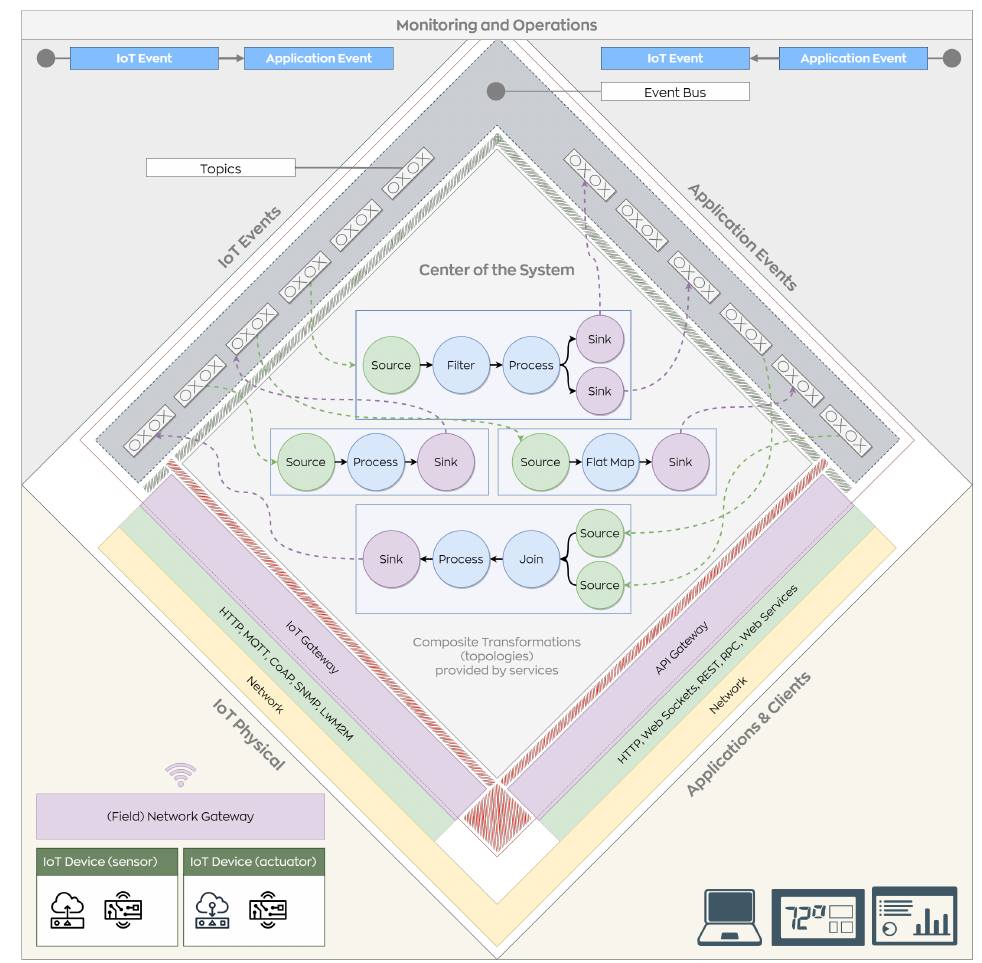
Figure 2. Symmetrical layered Architecture enables parametric Complex Event